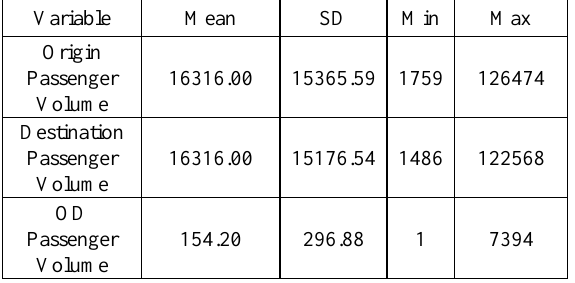
Table 1 : Descriptive Statistic of MRT trip